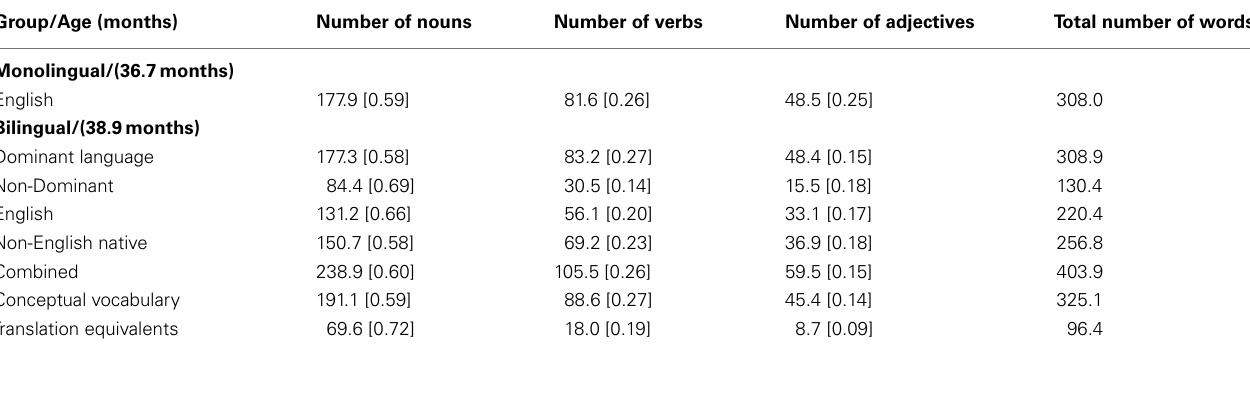
Table 2 | Mean productive vocabulary of languages based on the MacArthur–Bates Communicative Development